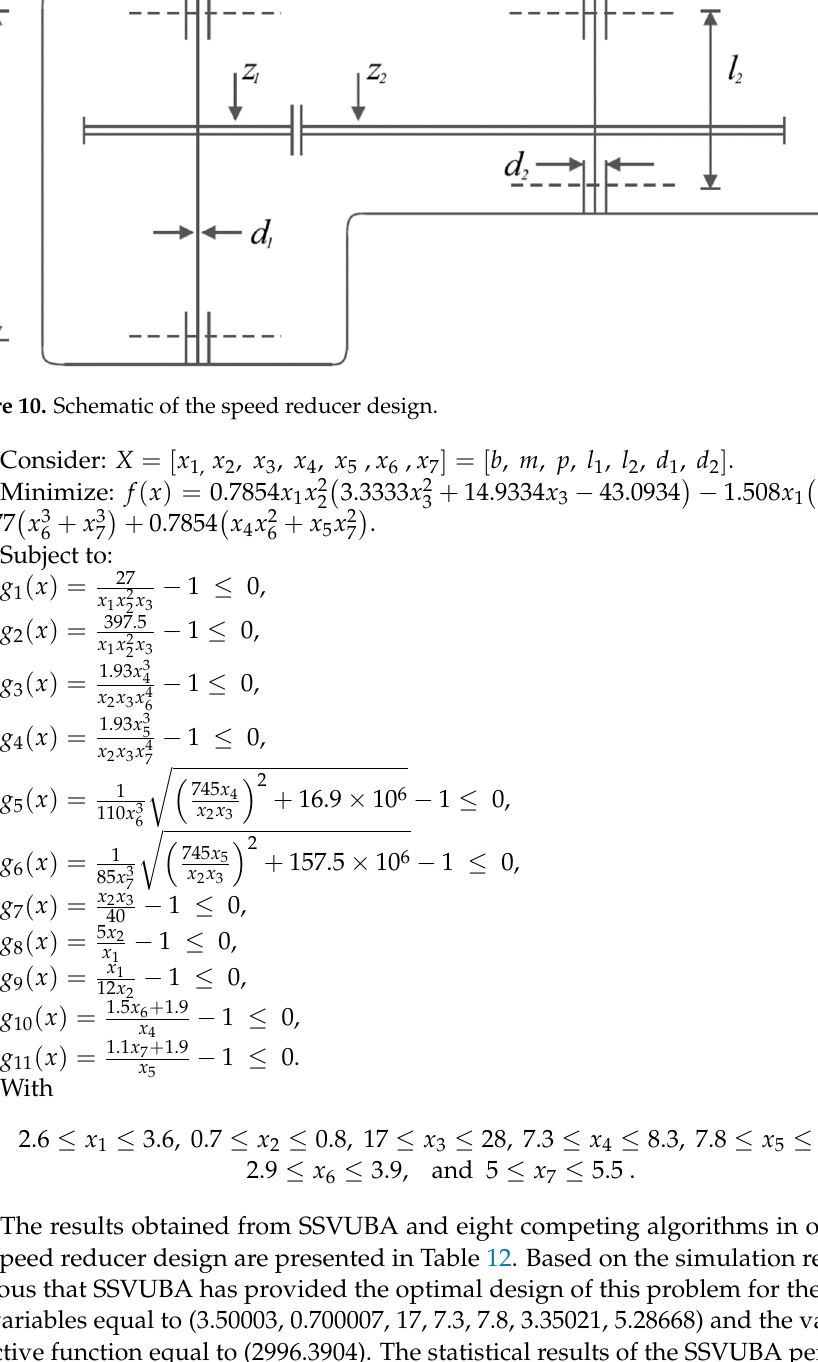
Table 13. Statistical results of optimization algorithms for the speed reducer design problem.